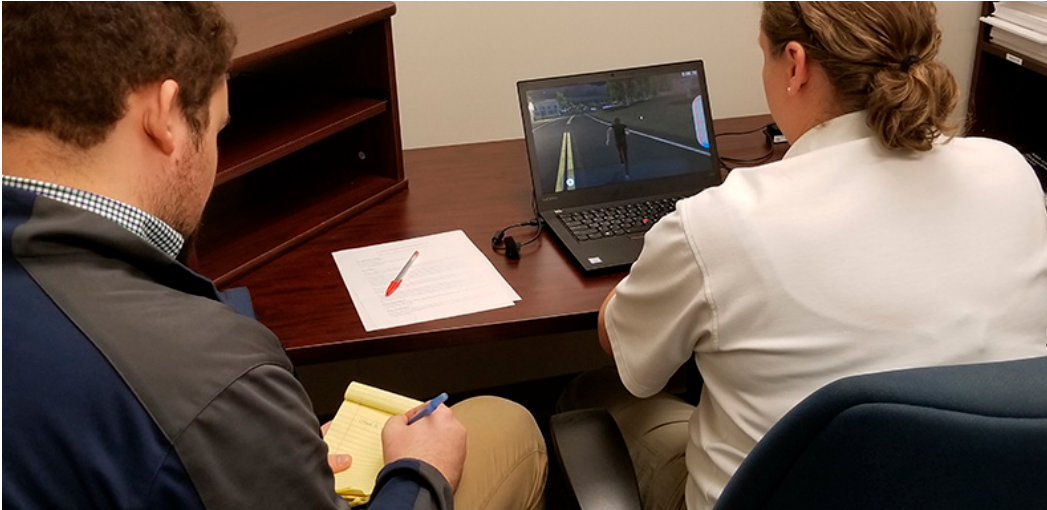
Figure 7. Think aloud evaluation of Project Lily Pad in Galveston County, Texas, with an emergency management professional who was an actual responder to Hurricane Harvey in 2017.